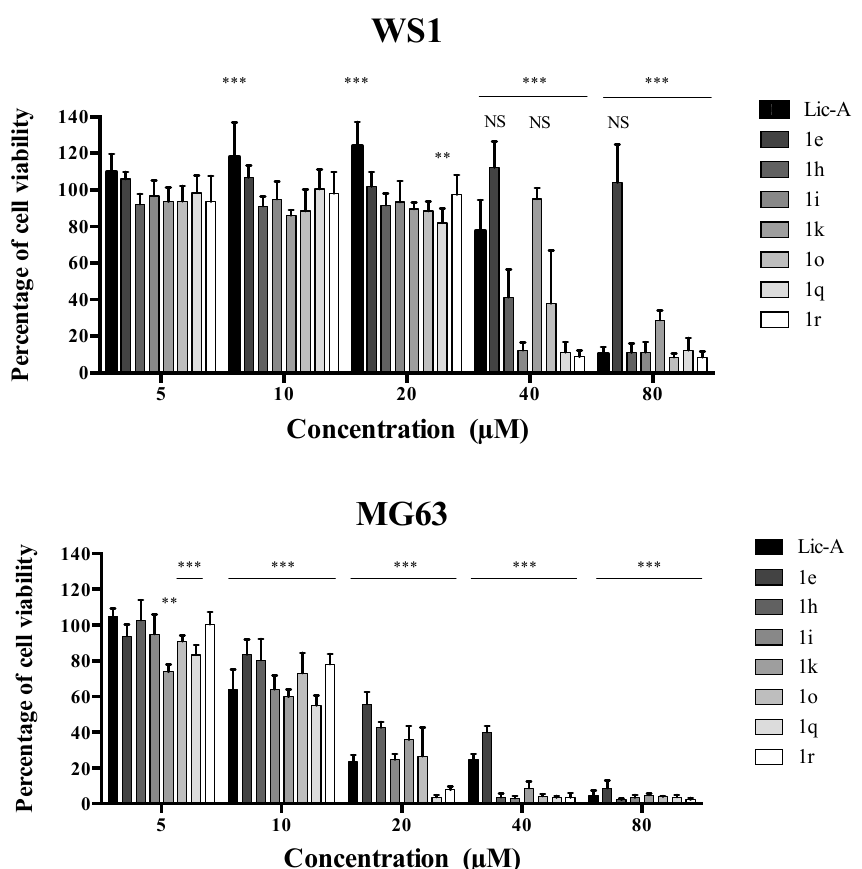
Figure 4. Comparative analysis of chalcone effects on cell viability in WS1 normal human fibro- blasts and MG63 cells. Cells were treated with five different concentrations (80, 40, 20, 10, and 5 µM). MTT assay was performed 48 h after treatment. Two-way ANOVA was performed, and all treatments were analyzed against control, ** p < 0.01, *** p < 0.001, and NS not statistically significant. Note that the data for MG63 are reported from Figure 3 and shown only for comparison.